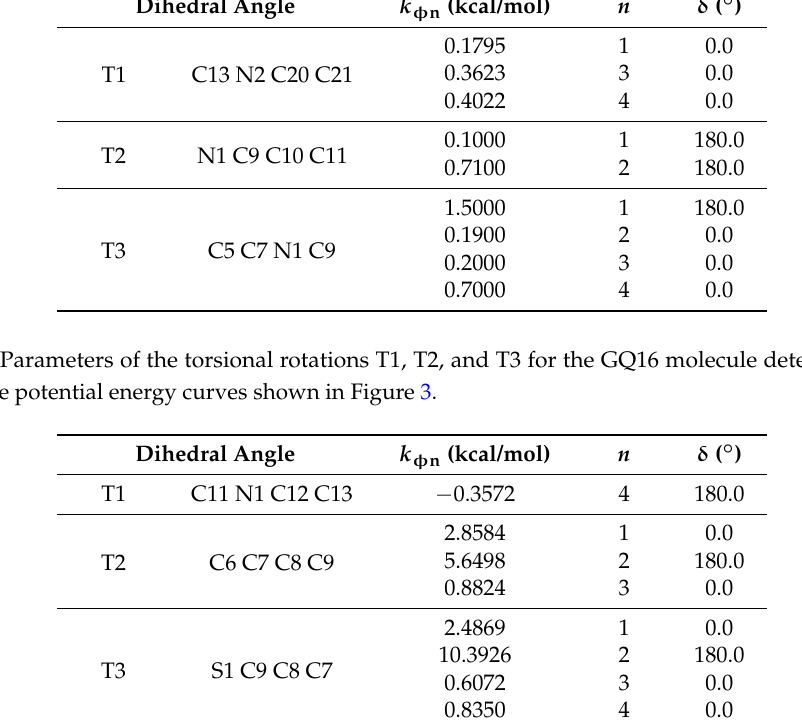
Table 1. Parameters of the torsional rotations T1, T2, and T3 for the SR1664 molecule determined by fitting the potential energy curves shown in Figure 2.